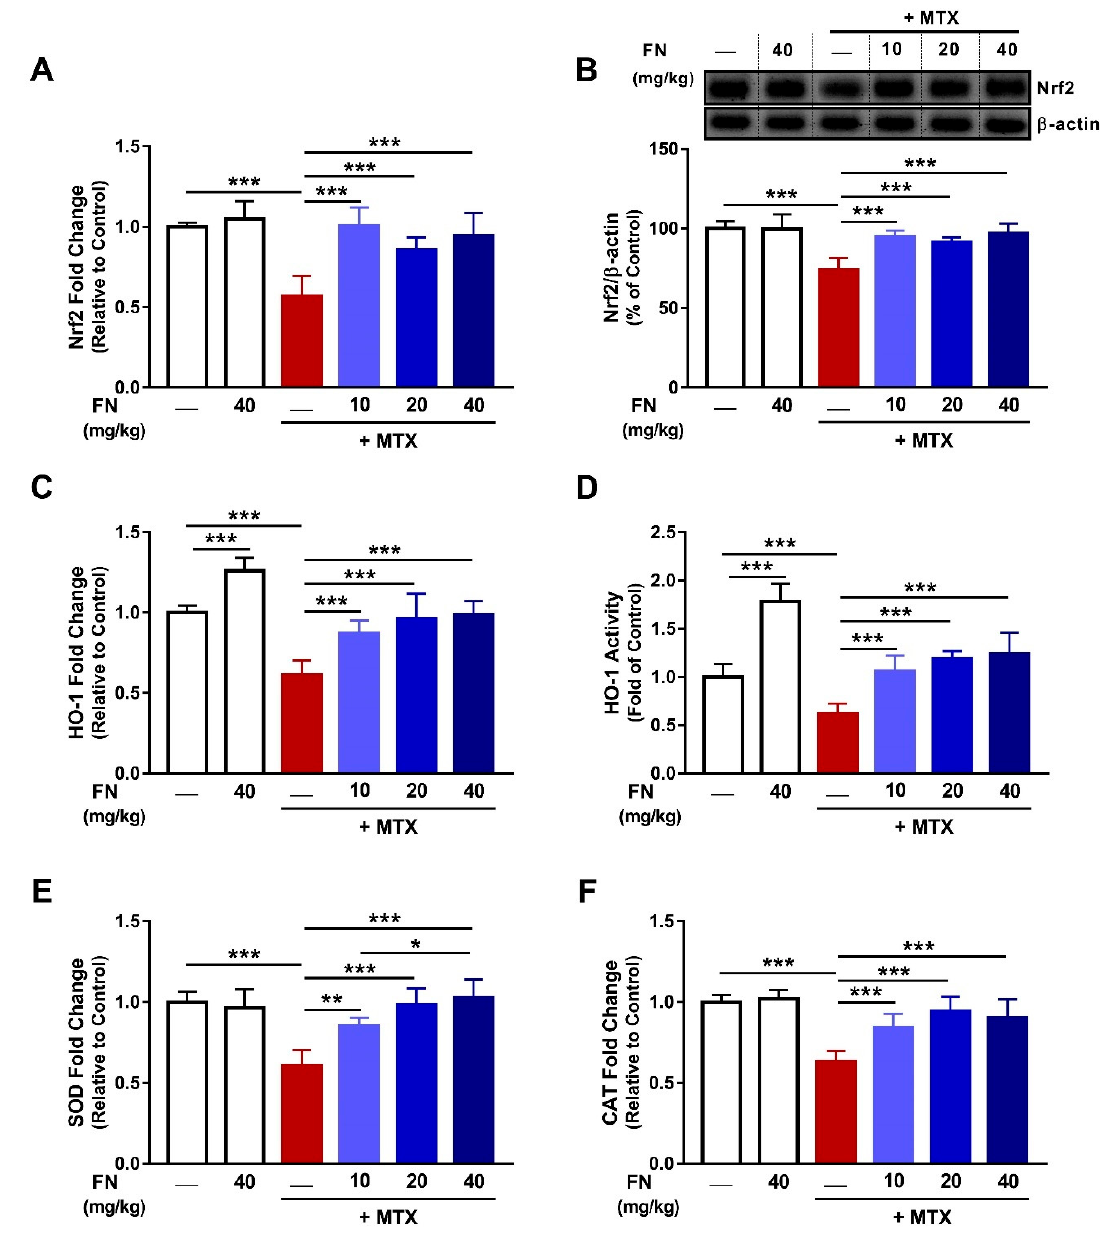
Figure 4. FN upregulates nuclear factor (erythroid-derived 2)-like 2 / heme oxygenase 1 (Nrf2 / HO-1) signaling in the kidney of MTX-administered rats. FN increased mRNA ( A ), and protein ( B ), levels of Nrf2, HO-1 mRNA ( C ), and activity ( D ), and mRNA of SOD ( E ) and CAT ( F ) in the kidney of rats received MTX. FN increased renal HO-1 mRNA (C) and activity (D) in normal rats. Data are mean ± SEM, ( n = 6). * p < 0.05, ** p < 0.01 and *** p < 0.001.